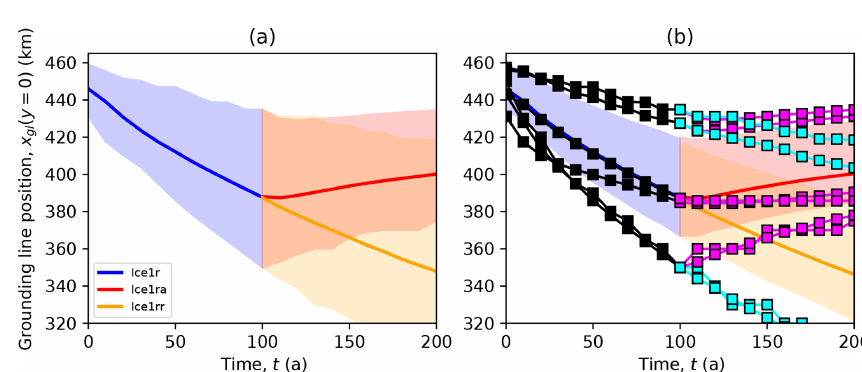
Figure 5. Rates of change in midchannel grounding line position x gl (y = 0 ) plotted against rates of change in volume above flotation V f (a) and grounded area A g (b) . For all three of the Ice1r, Ice1ra, and Ice1rr experiments each point (cid:16) (cid:49)x (cid:17) (cid:49)A g gl (y = 0 ) , as do the points , despite the considerable variation between models. (cid:49)t (cid:49)t